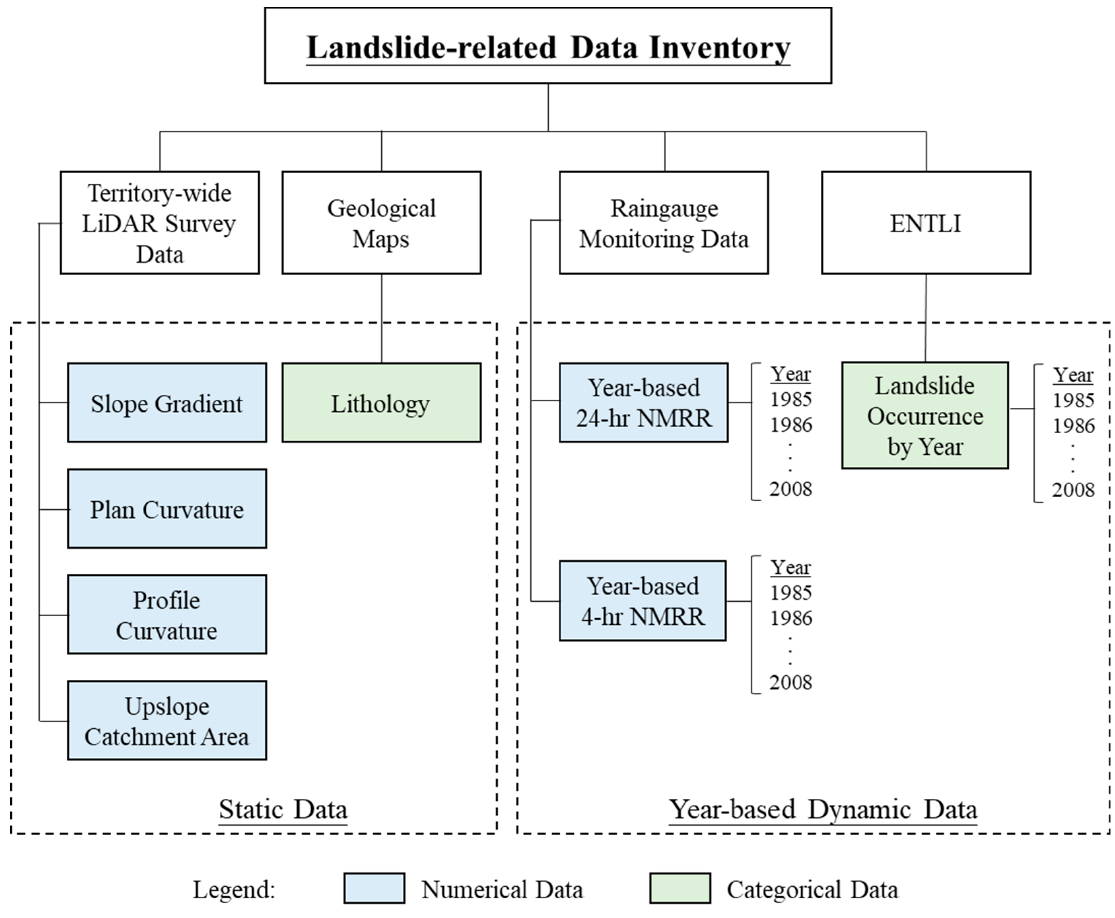
Figure 7. Available Dataset in a Grid.